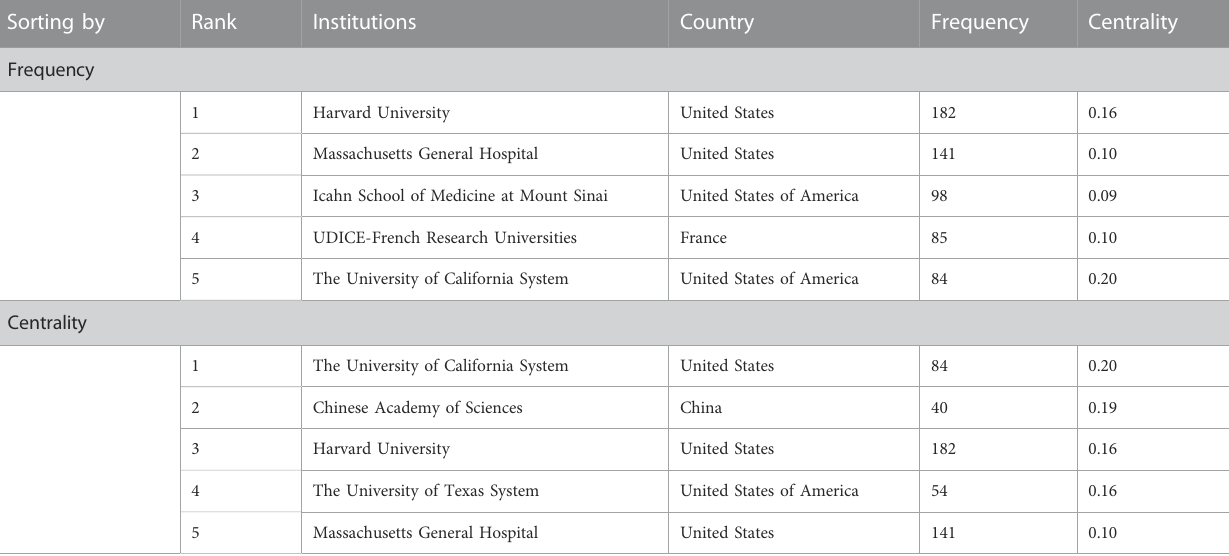
TABLE 2 Top fi ve institutions that contributed to publications on molecular imaging research in AS. Sorting